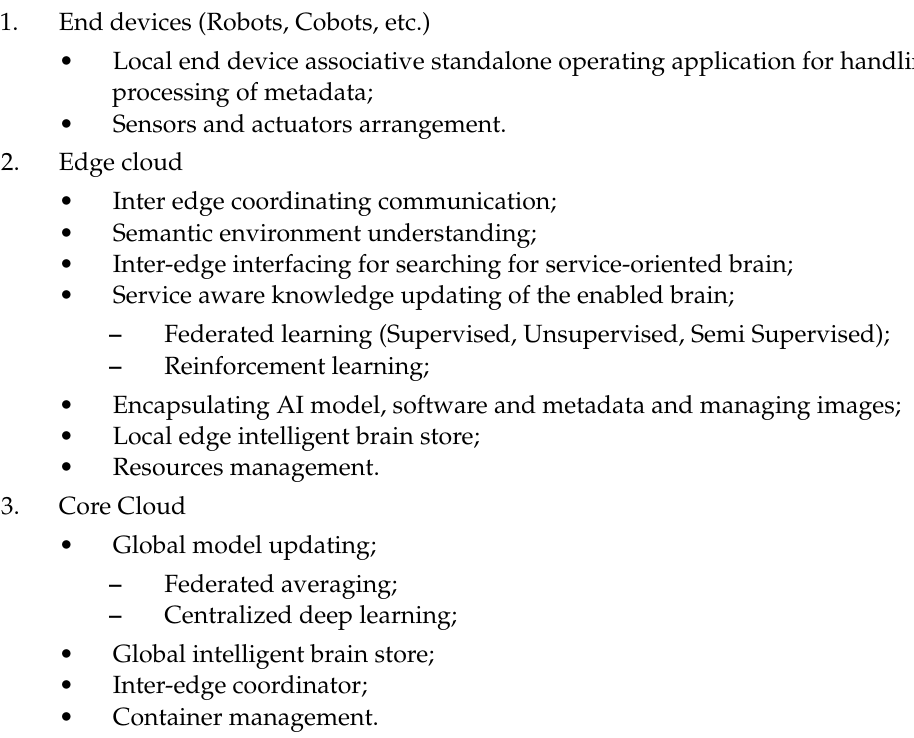
Figure 2. A single operational flow between edge devices and edge cloud with